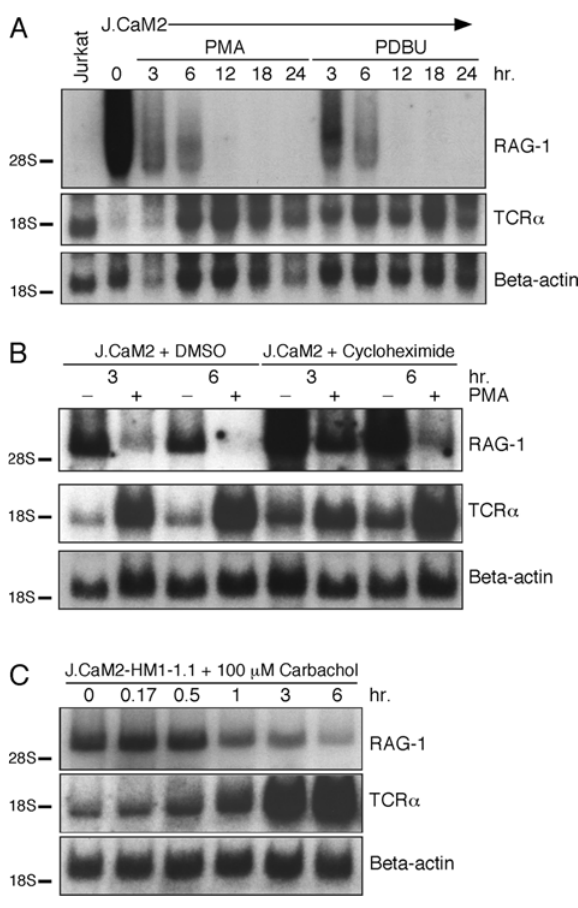
Figure 2. Stimuli Bypassing LAT Deficiency in J.CaM2 Reduce Elevated RAG-1 Expression (A) LAT-deficient J.CaM2 cells were stimulated with PMA or PDBu and analyzed for RAG-1 mRNA expression by Northern blot analysis. In (A), (B), and (C), the same blot was hybridized with a fragment encoding the constant region of TCR a and with b -actin to control for stimulation and loading. (B) Analysis of PMA-induced reduction of RAG-1 expression levels in absence of protein synthesis blocked by cycloheximide treatment of J.CaM2 cells. Control hybridizations were carried out by hybrid- ization with the constant region of TCR a and with b -actin . (C) Analysis of RAG-1 transcripts in J.CaM2-HM1-1.1 cells stimulated for various time intervals with carbachol to trigger the human muscarinic (HM) receptor subtype I on the surface of these